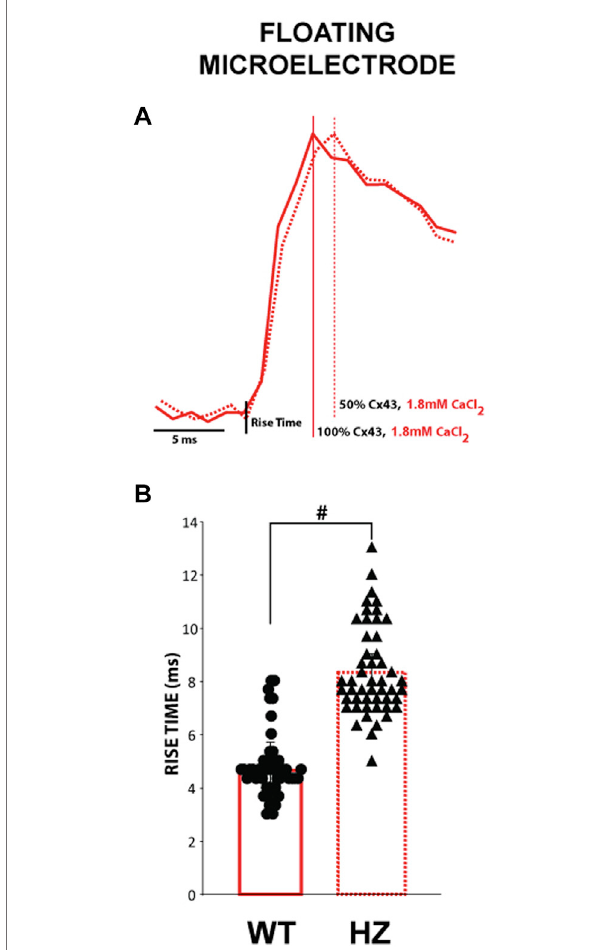
FIGURE 6 | The time to peak for APs measured from Cx43 HZ hearts is greater than that of WT hearts. (A) Representative fl oating microelectrode recordings of the depolarization phase of ventricular APs measured along the transverse axis of propagation from an epicardially placed stimulating electrode. (B) . Summary data of the time from phase 4 to the peak of phase 0 depolarization(timetopeak)fromWTandCx43HZhearts.ReducingCx43by 50%increasedthetimetopeak.#, p < 0.01withnestedone-wayANOVA,( n = 3 WT hearts, n = 3 HZ hearts, 50 action potentials per